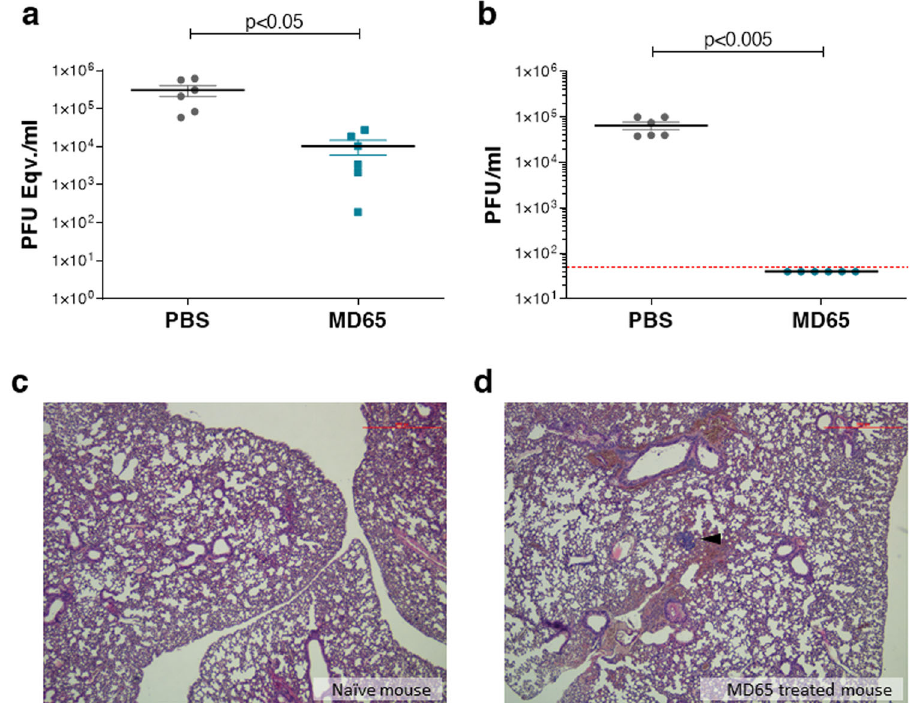
Fig. 4 Viral load determination and histological analysis of lungs, collected from K18-hACE2 mice, infected with SARS-CoV-2, and treated 2 dpi with MD65 antibody. a , b Viral load in lung samples, collected 6 dpi from PBS-treated mice ( n = 6, gray dots) and mice treated 2 dpi with 1 mg MD65 antibody ( n = 6, turquoise dots). a Viral load was quanti fi ed by qRT-PCR and expressed as equivalents of PFU/ml. b Infectious viral load determined by plaque assay. Dotted red line indicates the assay limit of detection. Data in a , b represent individual values and mean ± SEM. Horizontal bars indicate statistical signi fi cance of paired values. P values calculated using two-tailed paired t -test were: in panel a — 0.0295 and in panel b — 0.0031. c , d Histological analysis of lung sections, collected 21 dpi from a naïve mouse ( c ) and a mouse that was infected with SARS-CoV-2 and treated 2 dpi with 1 mg MD65 antibody ( d ); black arrow indicates lymphoid aggregate. The panels include representative images ( n = 2 for the naïve mice and n = 6 for the MD65-treated mice, which were independently infected and analyzed, yielding similar results; full images of the lungs are provided in Supplementary Fig. 3). Magni fi cation =